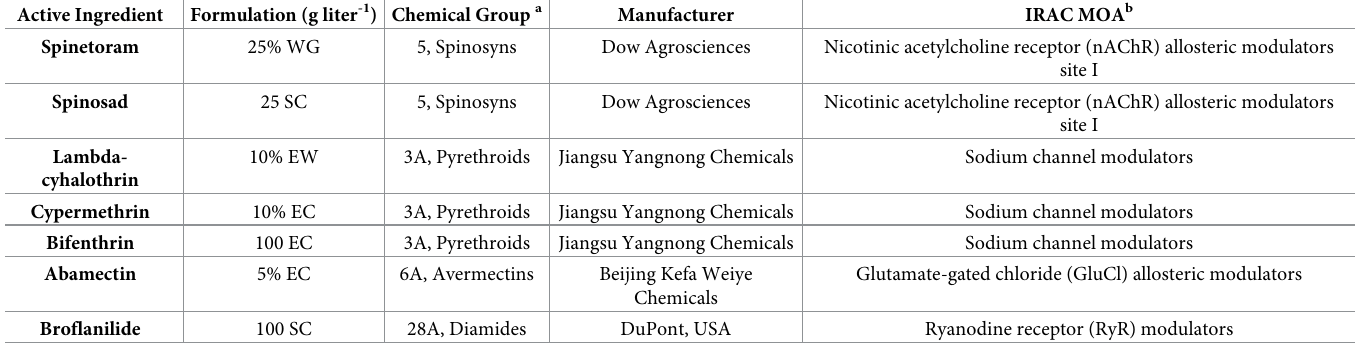
Table 1. Insecticide formulations tested against S . frugiperda larvae including active ingredients, formulation type, concentrations, chemical group and respective mode of action. Active